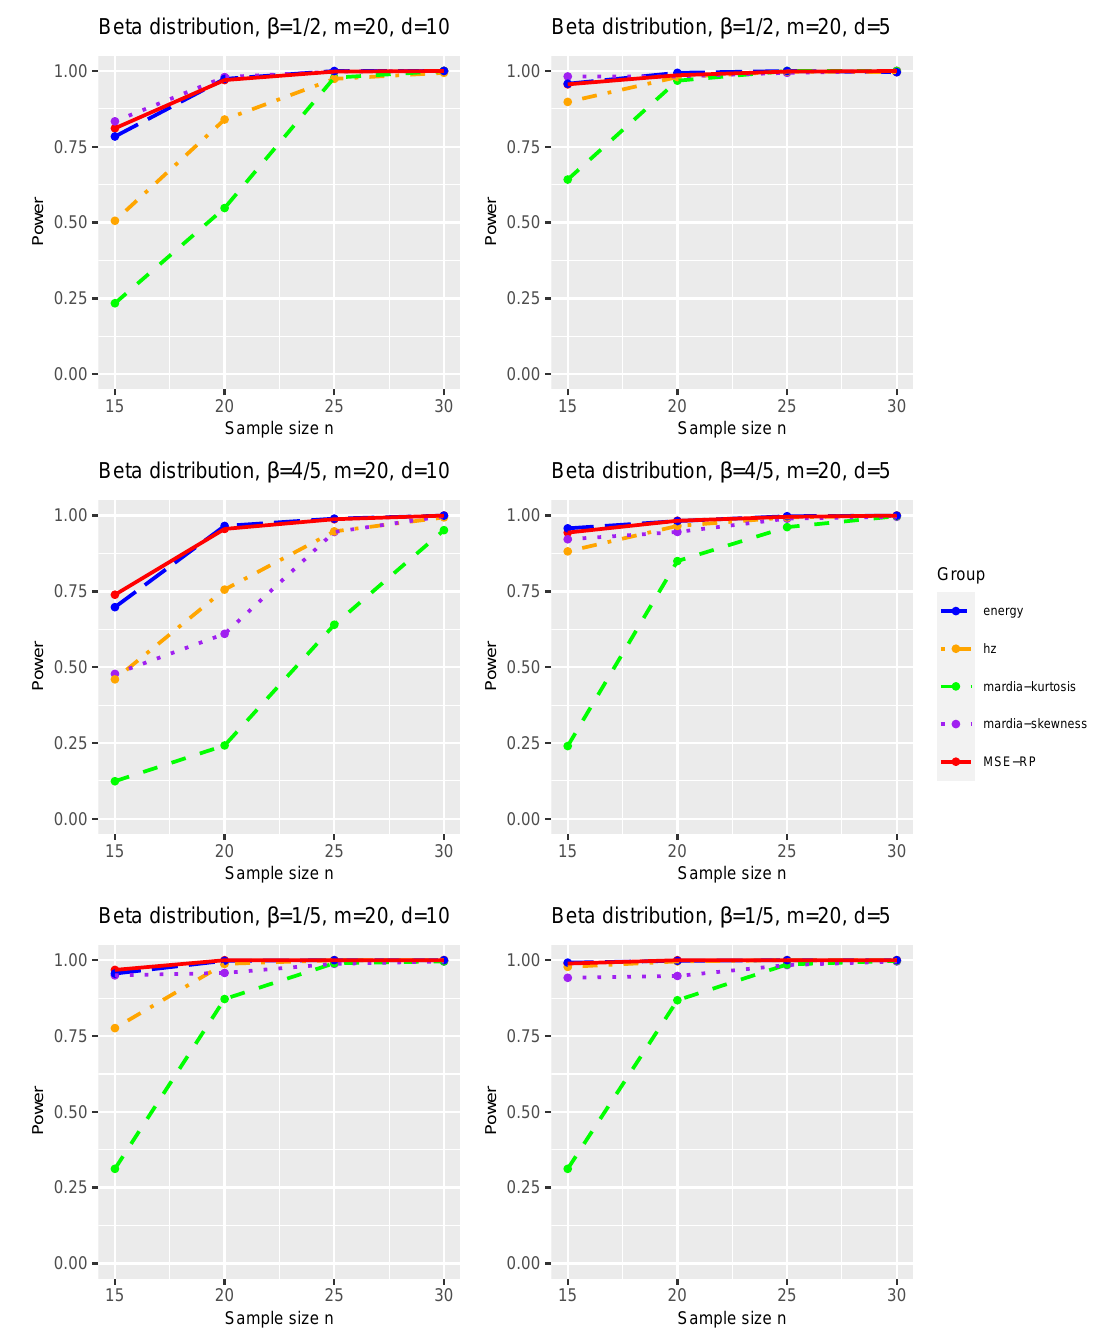
Figure 7. Power ( α = 0.05) comparison in β g-normal